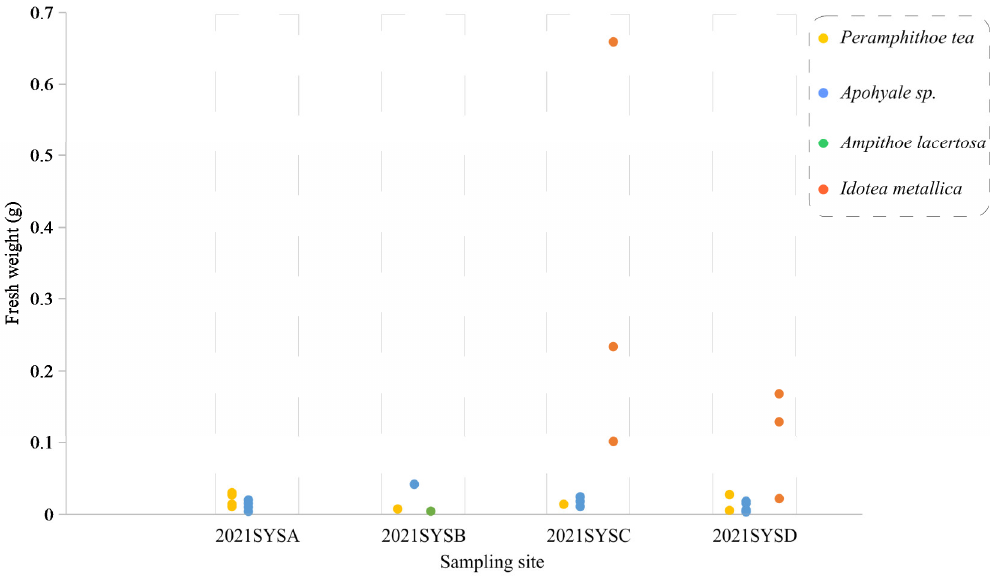
Figure 7. Scatter graph of fresh weight of epizoans from each site.